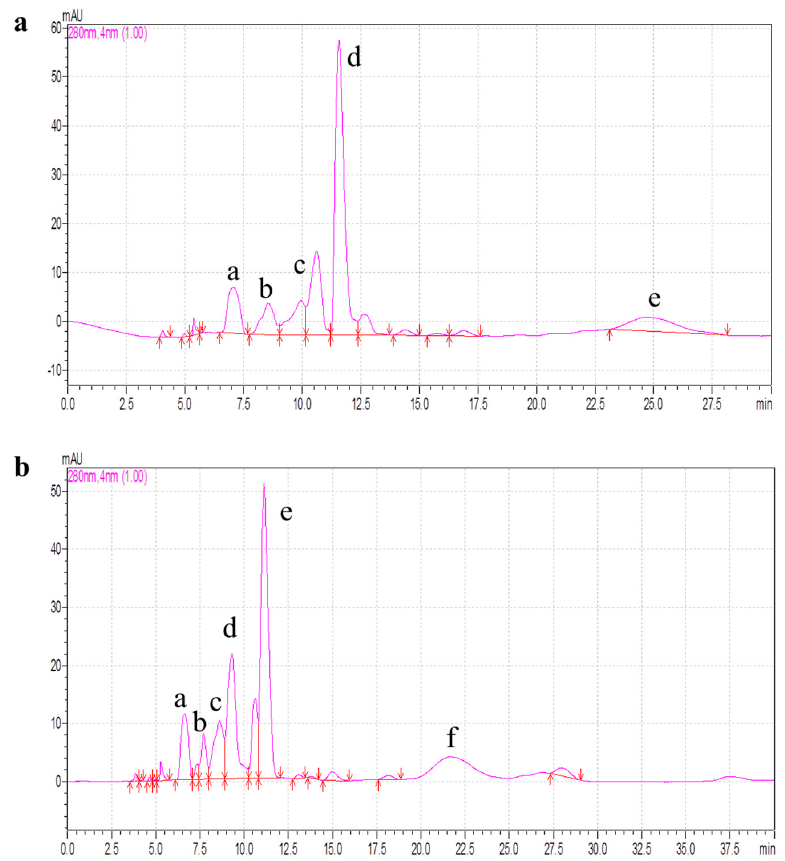
Figure 6. RP-HPLC chromatograms of ( a ) PCPH-IV-B1 (PCPH-IV-B1 was divided into five major fractions, labeled as a, b, c, d, e); and ( b ) PCPH-IV-B2 (PCPH-IV-B2 was divided into six major fractions, labeled as a, b, c, d, e, f).